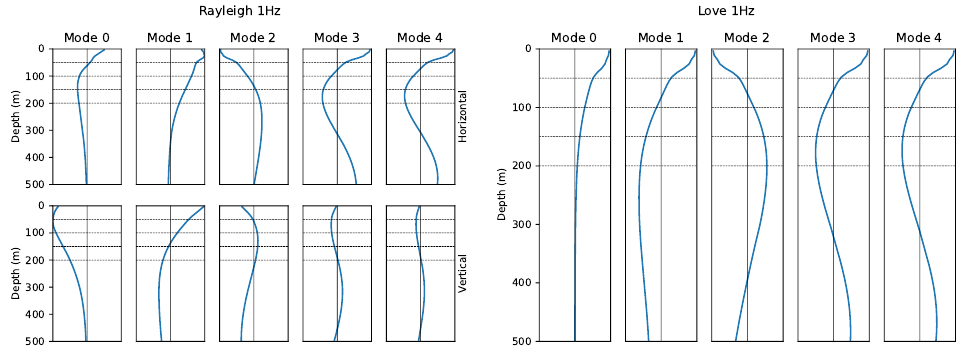
Figure 6. Eigen-mode amplitudes as function of depth for Rayleigh waves (amplitudes of both the horizontal and vertical components normalized to preserve amplitude ratios) and Love waves at 1